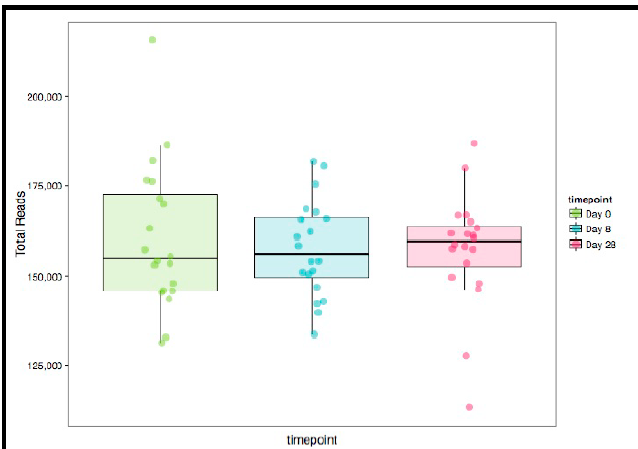
Figure 2. Box and whisker plots of sample library size with each point representing the number of reads in the sample in the three groups (Day 0, 8, 28). No significant differences were observed in any of the variables in the three time points evaluated (ANOVA for repeated measures).